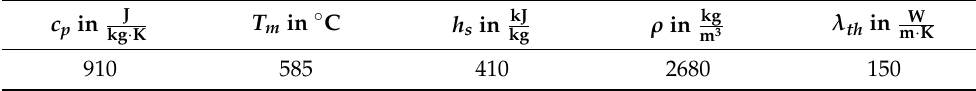
Table 1. Material properties used for AlSi10Mg